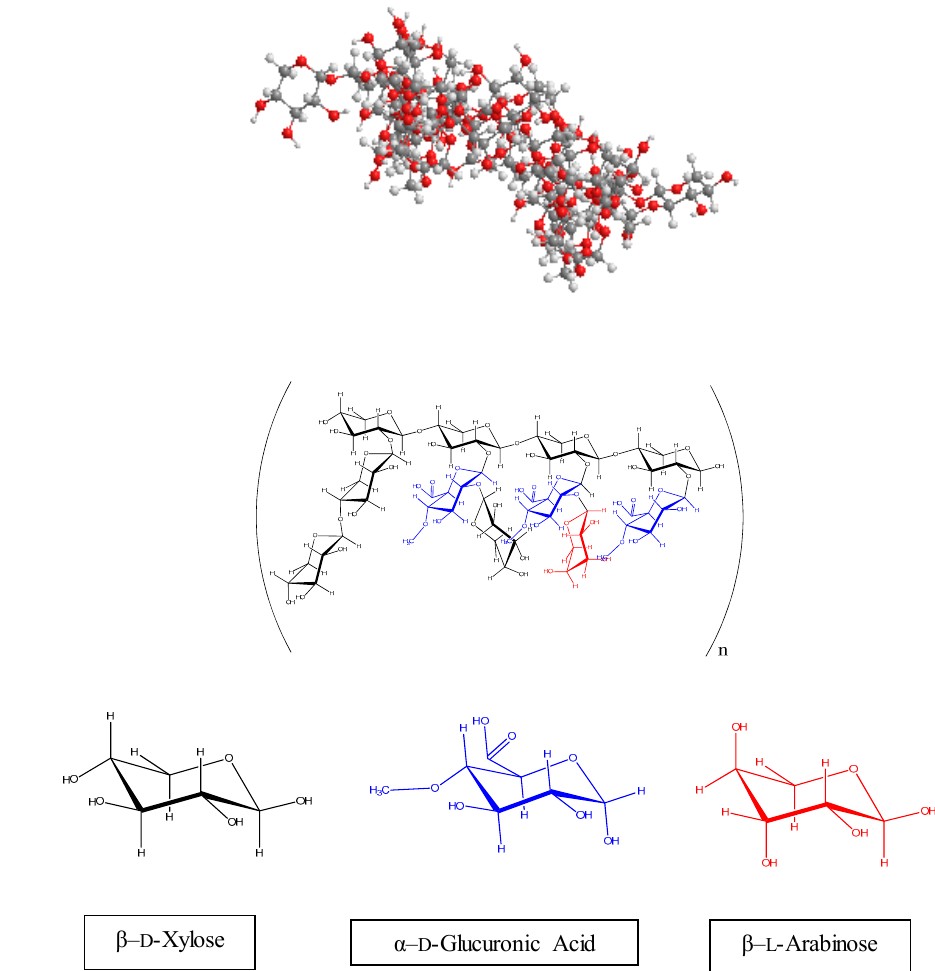
Figure 1. ( a ) Three-dimensional schematic representation of chemical structure of BG (chain portion: black = carbon; red = oxygen; gray = hydrogen); ( b ) two-dimensional structure.